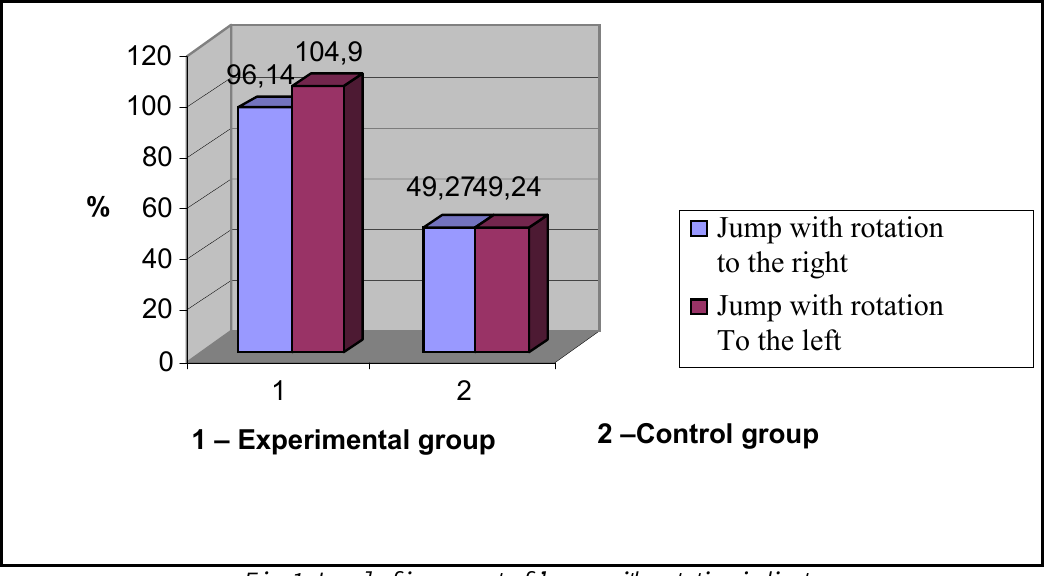
Fig. 1. Level of increment of jhump with rotation indicators